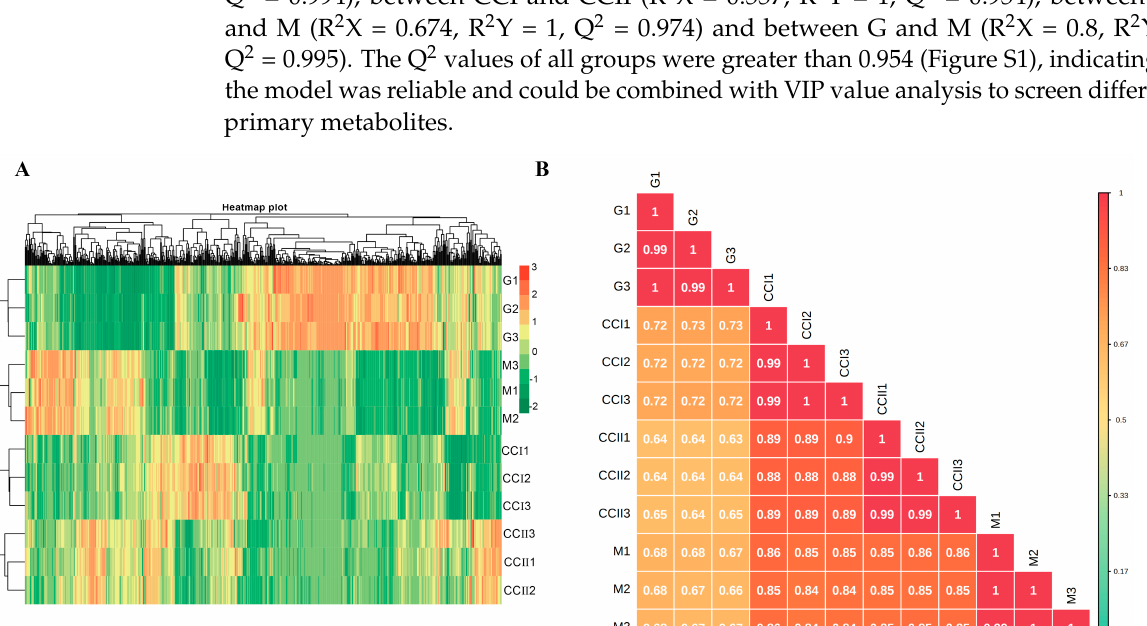
Figure 1. Differential fruit chemotype between ‘Shushanggan apricot’ fruits at four developmental stages. ( A ): Heat map of the identified metabolites; ( B ): Correlation analysis of four sets of samples; ( C ): Principal component analysis of metabolomics data (PCA 3D plot); ( D ): Orthogonal signal cor- rection and partial least squares-discriminant analysis. Based on the KEGG database, the metabolic pathway enrichment of differential me- tabolites was investigated to understand the variation mechanisms of differential metab- olites in the fruit development stage. The KEGG enrichment analysis demonstrated that the differential metabolites of G vs. CC I were significantly involved in glyoxylate and dicarboxylate metabolism, 2-oxocarboxylic acid metabolism, phenylpropanoid biosynthe- sis, linoleic acid metabolism and so on. For CC I vs. CC II, differential metabolites were allocated to the biosynthesis of secondary metabolites, biosynthesis of amino acids and purine metabolism. The differential metabolites of CC II vs. M were involved in the bio- synthesis of cofactors, biosynthesis of amino acids, 2-Oxocarboxylic acid metabolism and phenylpropanoid biosynthesis, etc. Based on the statistical significance criterion corrected by multiple tests (adjusted p -value), phenylpropanoid biosynthesis, biosynthesis of amino acids, biosynthesis of secondary metabolites and 2-Oxocarboxylic acid metabolism path- ways were significantly enriched ( p -value ≤ 0.001) during ‘Shushanggan apricot’ fruit de- velopment (Figure S2).